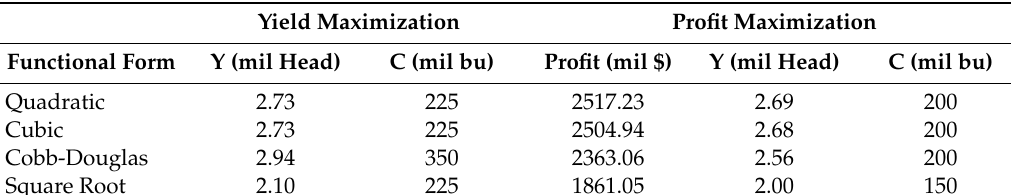
Table 4. Yield and profit-maximizing corn grain production rates, all models.